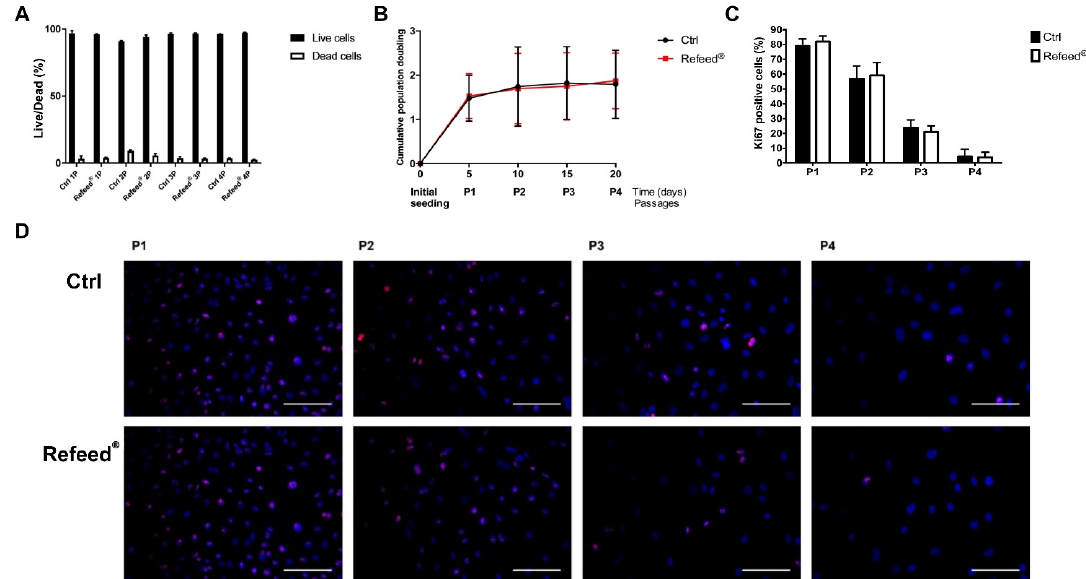
Figure 3. Analysis of viability and proliferation in human Amniotic Epithelial Cells (hAECs) cultured with and without Refeed ® supplementation. hAECs were cultured in basal medium (Ctrl) and in basal medium supplemented with Refeed ® . ( A ) Percentage of living and dead hAECs during passages (P1–P4). ( B ) cumulative population doubling vs. passages (P0–P4) or days. ( C ) Representative images of Ki67 marker (nuclear red signal) during passages (P1–P4); nuclei were stained with DAPI (blue signal). Immunofluorescence images were acquired using the Nikon Inverted Microscope equipped with a Digital Sight camera DS-03. Scale bars: 100 μ m. ( D ) Percentage of red-stained Ki67 positive cells from P1 to P4. Data are expressed as mean ± standard deviation (SD). The experiment was performed on three human samples in technical triplicate.